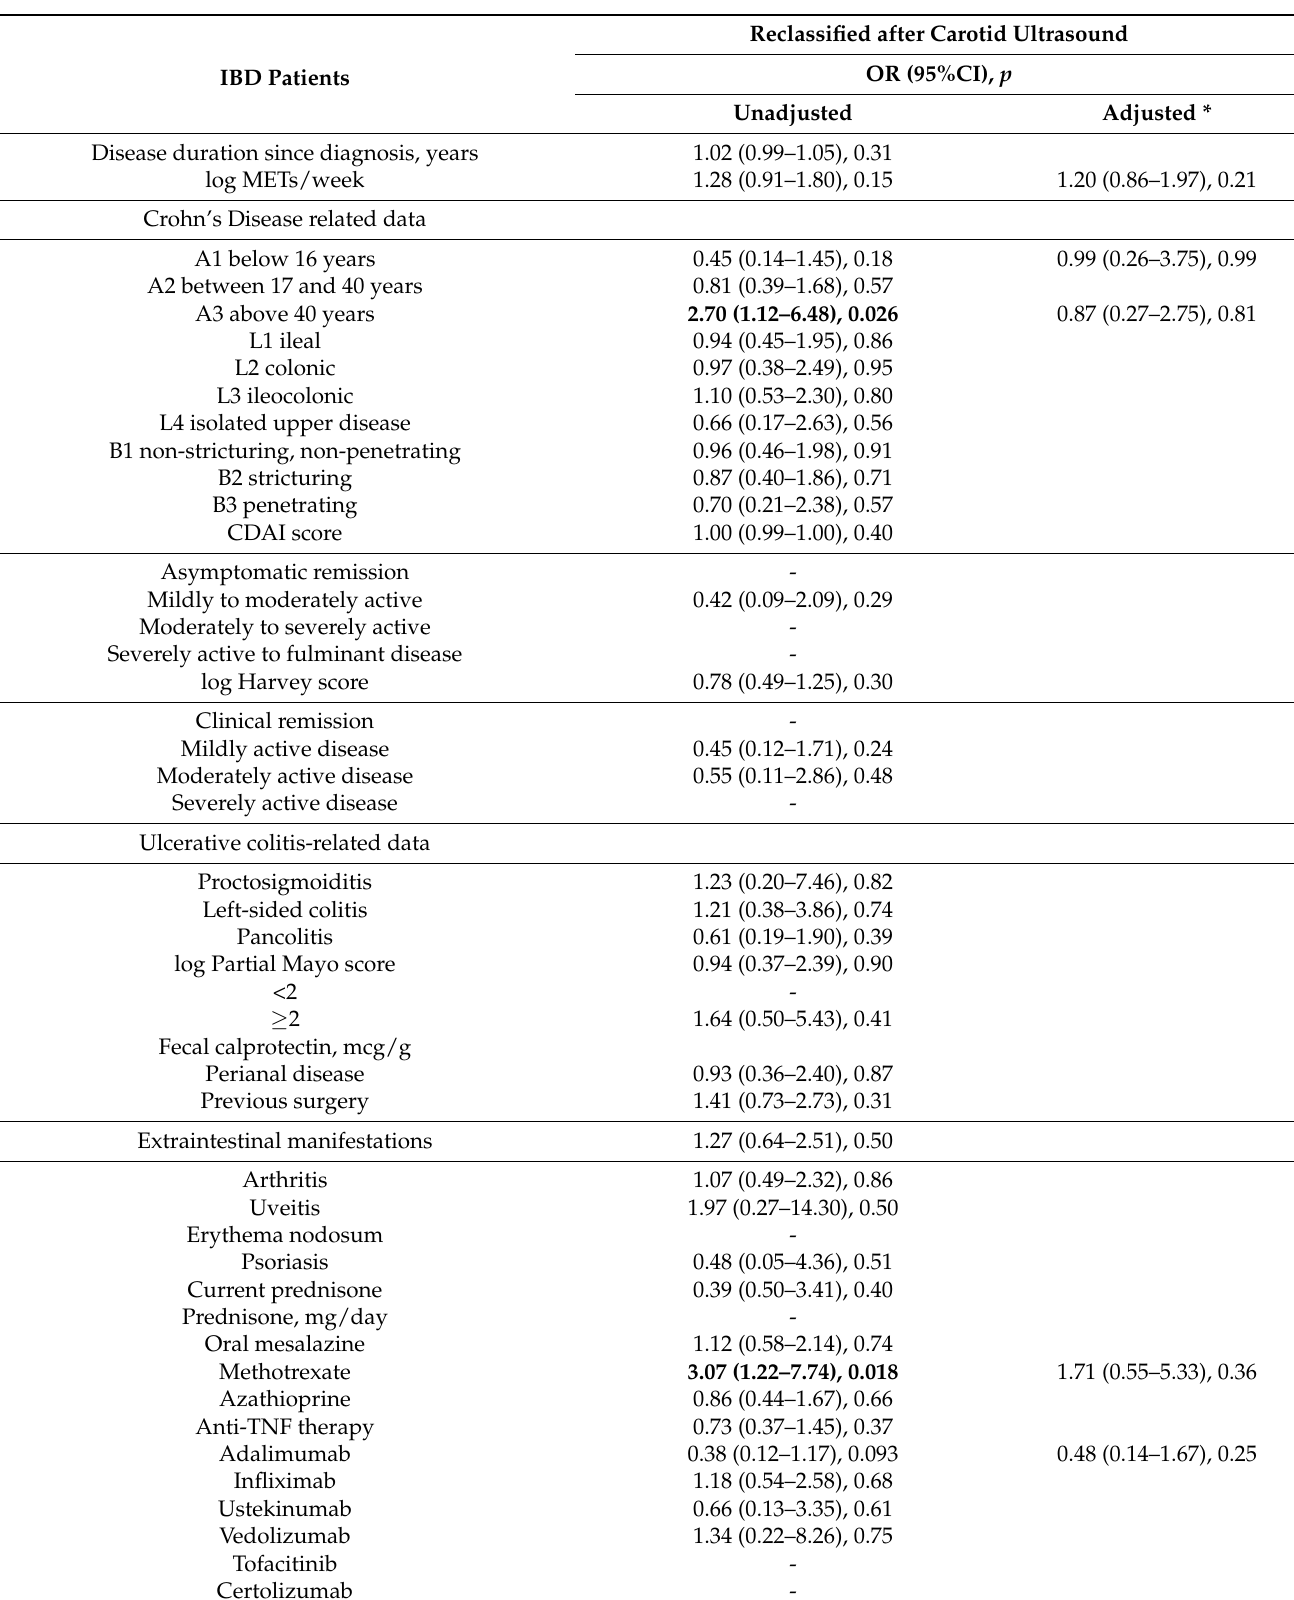
Table 4. Disease-related data association with